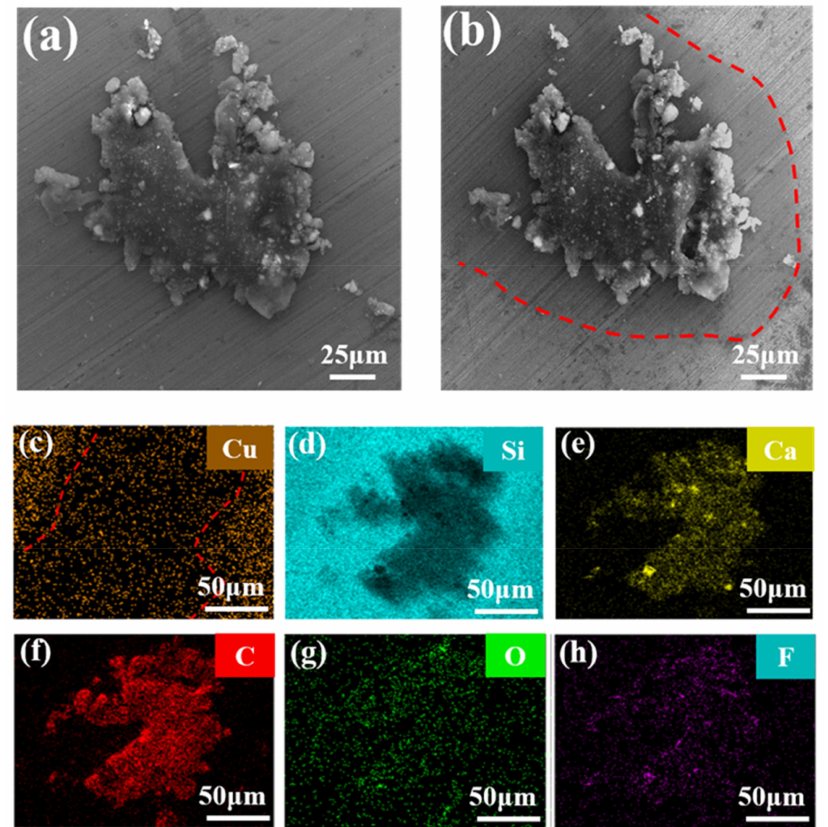
Figure 7. ( a ) SEM image of white-spot-stained silicon wafer before and ( b ) after deposition, ( c ) elemental distribution of Cu, ( d ) Si, ( e ) Ca, ( f ) C, ( g ) O, and ( h ) F. (EDS maps in ( c – h ) were taken after